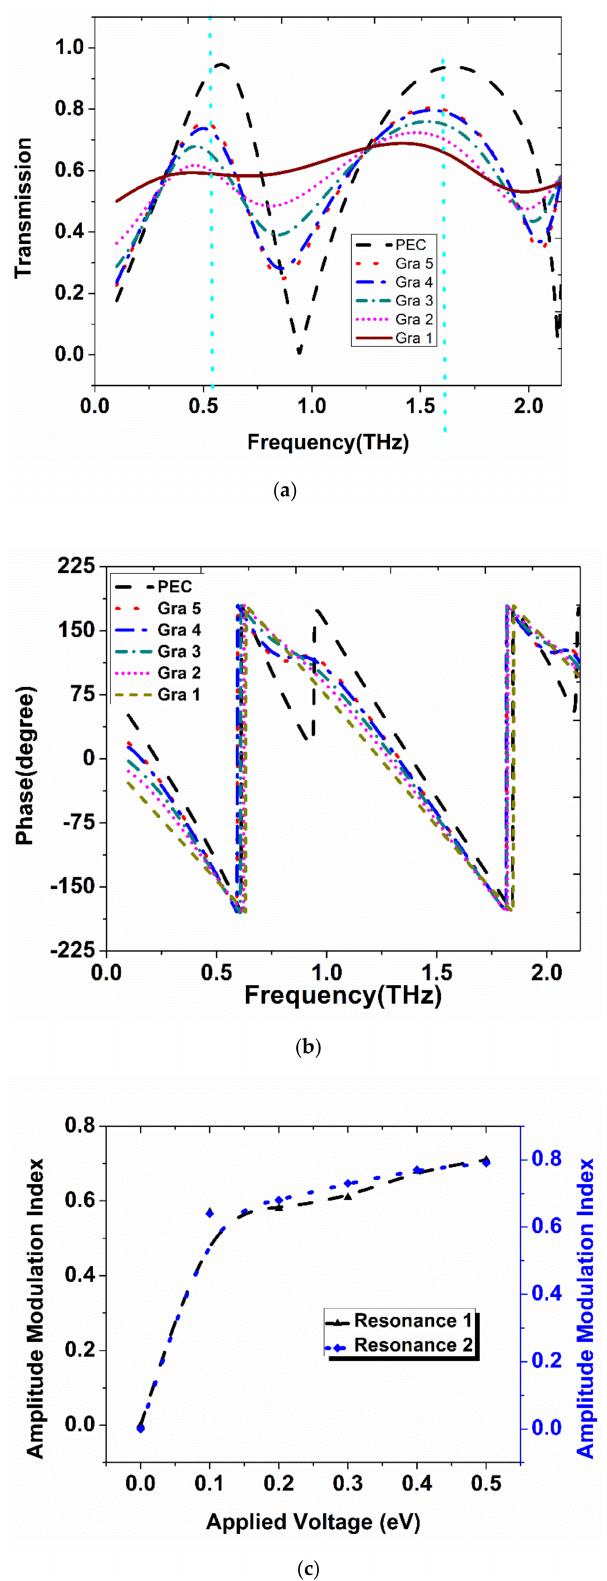
Figure 3. ( a ) Transmission spectra for graphene based MM for different Fermi levels Gra1 =0.1 eV, Gra2 = 0.2 eV, Gra3 = 0.3 eV, Gra4 = 0.4 eV, Gra5 = 0.5 eV, respectively (in addition to PEC). ( b ) The corresponding frequency versus phase characteristics. ( c ) Fermi level versus amplitude modulation index for the obtained two